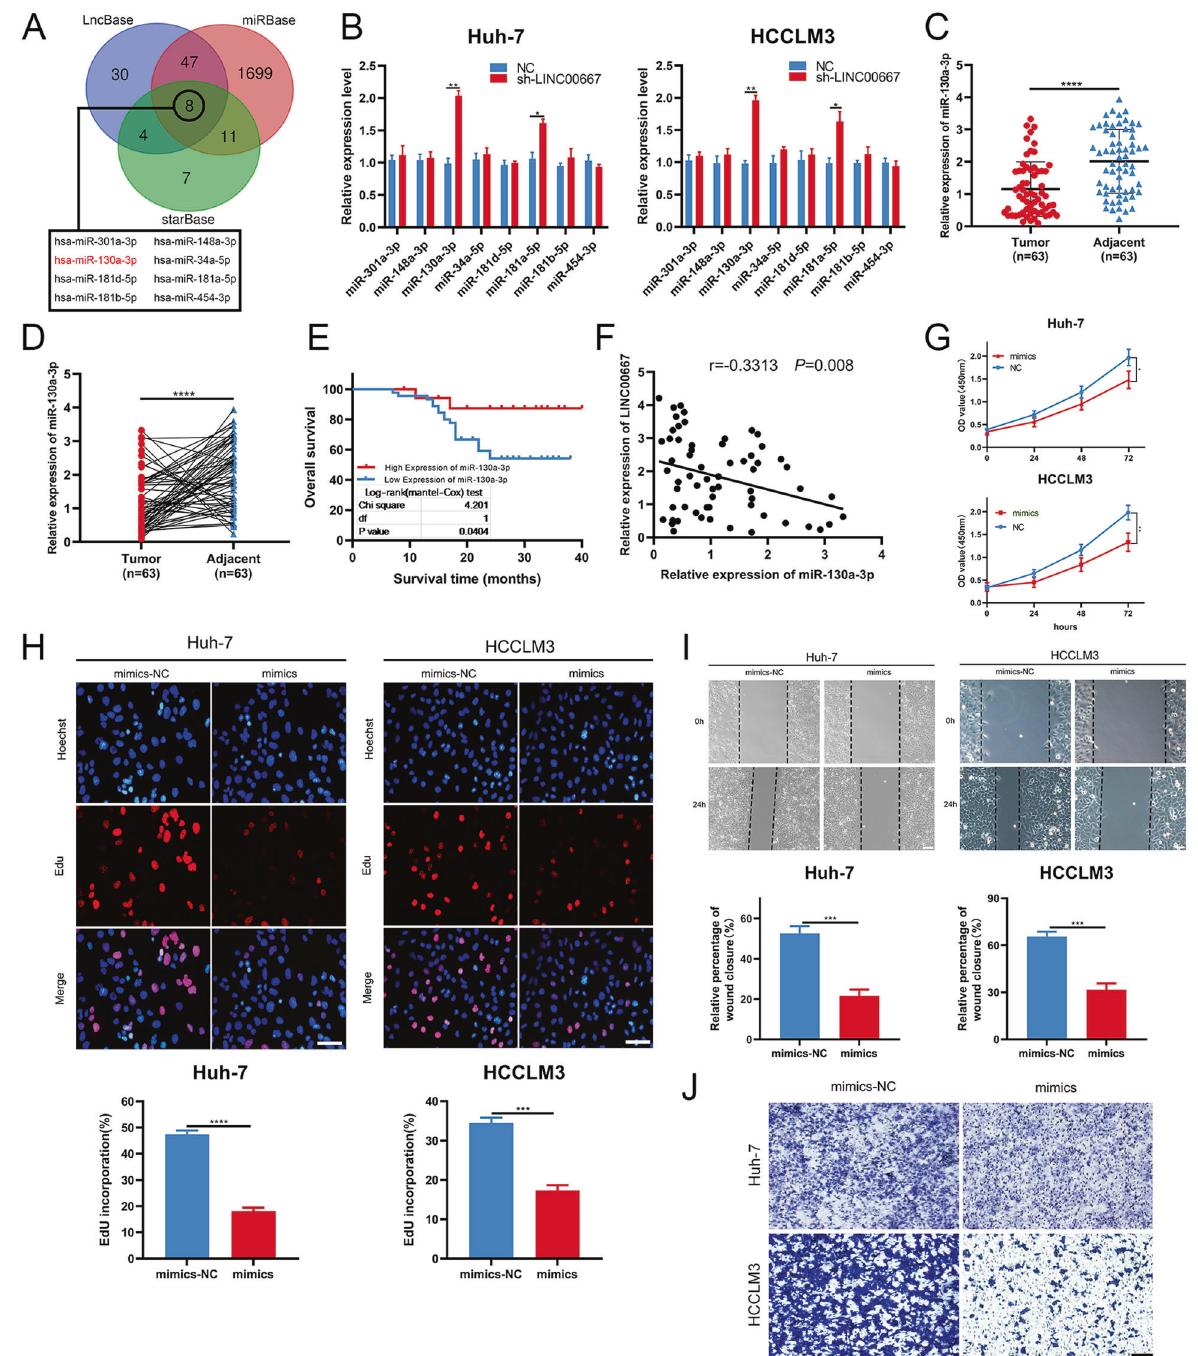
Fig. 3 miRNA-130a-3p suppresses CP, CM and CI in HCC cells. A Using starBase, LncBase and miRBase, LINC00667 was targeted by 8 miRNAs. B Relative expression of candidate miRNAs in HCCLM3 and Huh-7 cells, miRNA-130a-3p was selected for further analyses. Data ( n = 3) were analyzed by student ’ s t test. C and D Expression levels of miRNA-130a-3p in HCC and paired adjacent tissues were determined by RT-qPCR assay ( n = 63, paired t test). E Kaplan-Meier OS analysis of HCC patients with downregulated and upregulated miRNA-130a-3p expression. F Pearson ’ s correlation coef fi cients of the relationship between LINC00667 and miRNA-130a-3p expression in HCC tissues. G and H Proliferative abilities of HCCLM3/Huh-7 cells transfected with mimics or mimics-NC were evaluated by CCK-8 and Edu assays, respectively. Scale bar, 100 μ m. Data were analyzed by student ’ s t test. I Migratory capabilities of HCCLM3/Huh-7 cells transfected with mimics or mimic-NC were determined by wound healing assays. Scale bar, 100 μ m. Data were analyzed by student ’ s t test. J Invasive capabilities of HCCLM3/Huh-7 cells transfected with mimics or mimic-NC were determined by transwell assays. Scale bar, 150 μ m. Data, mean ± S.D. *, **, *** and **** = P <0.05, < 0.01, < 0.001 and < 0.0001, LINC00667 promotes CP, CM, and CI in HCC cells through (Fig. 4E). The results demonstrated that the luciferase activities LINC00667/miRNA-130a-3p/AR axis of AR 3 ’ UTR-WT were noticeably decreased in miRNA-130a-3p We designed rescue experiments using miRNA-130a-3p inhibitor to mimic group, but these phenomena were not found in AR verify whether LINC00667 can promote tumor via LINC00667/miRNA- 3 ’ UTR-MUT group (Fig. 4F).